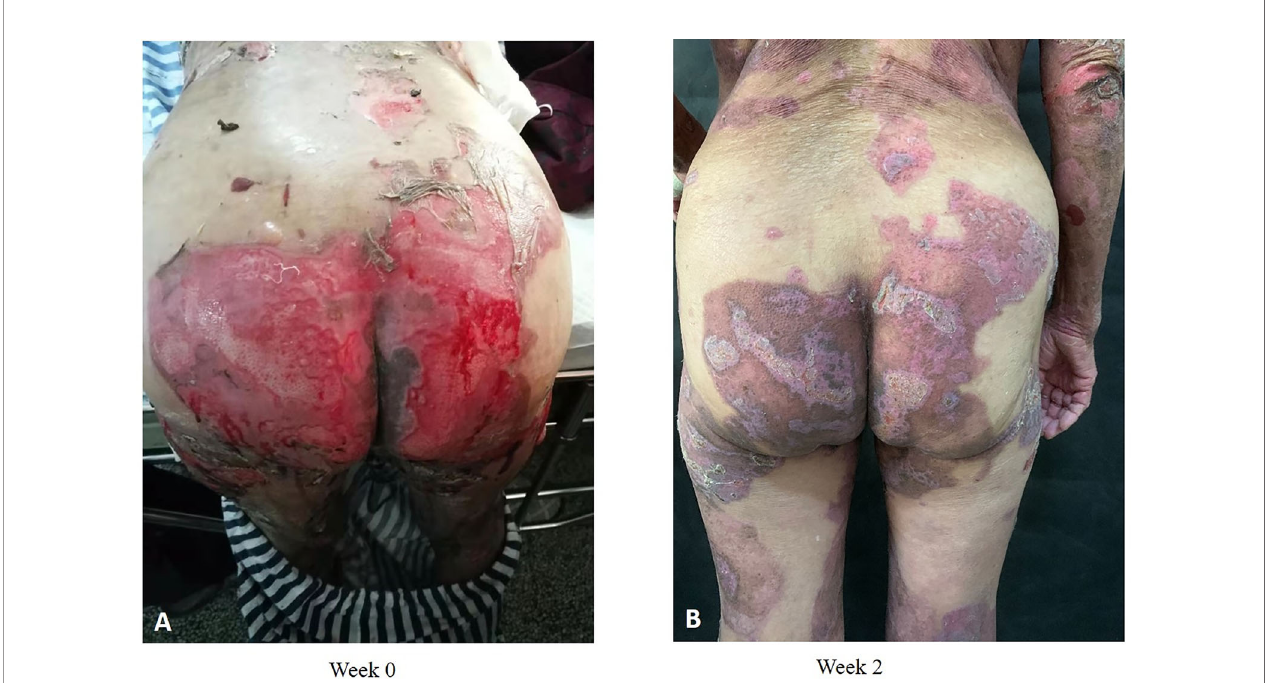
FIGURE 7 | Clinical photographs of one patient with BP who received dupilumab in combination with conventional therapy. Admission (A) ; 2 weeks after dupilumab (600 mg) treatment (B)